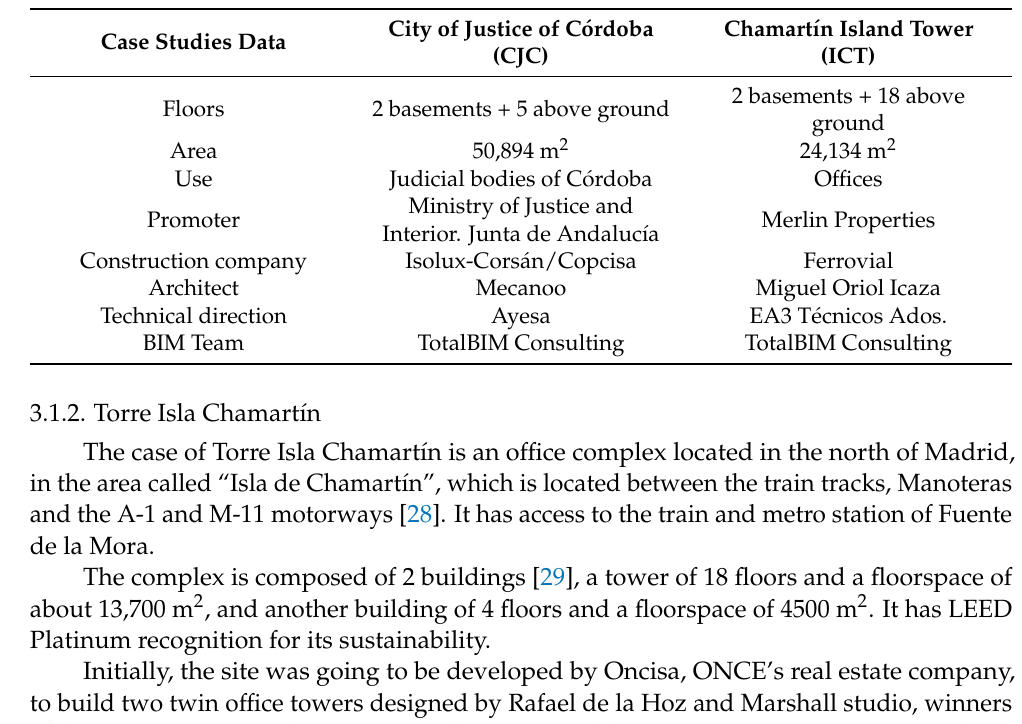
Table 1. General data of case